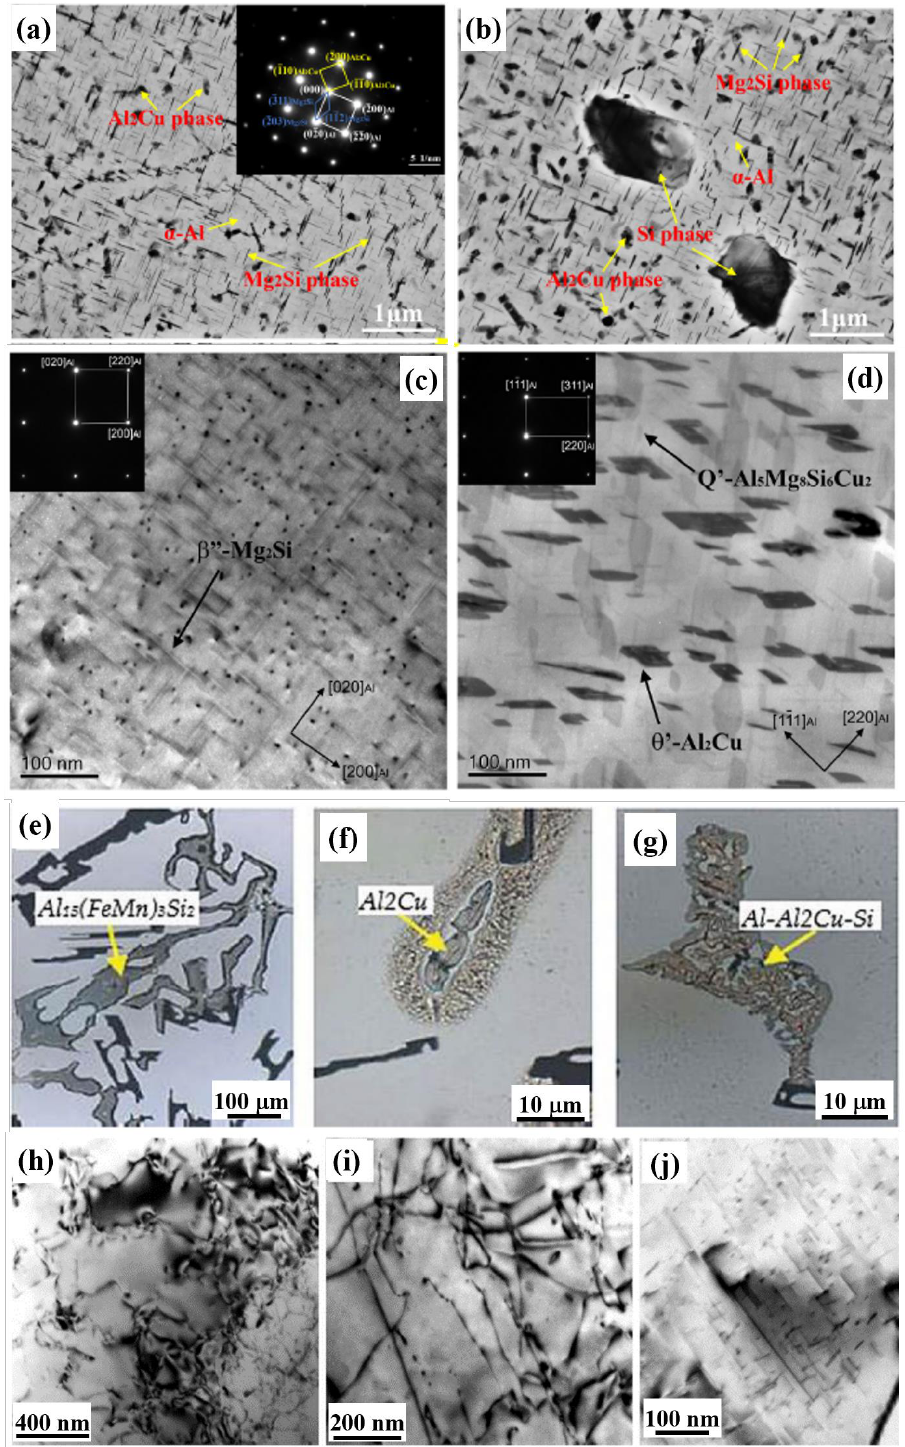
Figure 6. Bright-field (BF)-TEM images showing the presence of Mg 2 Si and Al 2 Cu precipitates in A319-T6 alloys at a cooling rate of ( a ) 0.1 °C/s and ( b ) 10 °C/s [62]. BF-TEM showing orientation and morphology of the precipitates formed in the α -Al matrix for ( c ) Al-7%Si-0.3%Mg-V-Zr alloy and ( d ) Al-7%Si-3%Cu-0.3%Mg-V-Zr alloy [65]. ( e – g ) Intermetallics precipitated in Al-9%Si-3%Cu recycled alloy [201]. TEM images showing the effect of heat treatment on the precipitation sequence in ( h ) T1, ( i ) T4, and ( j ) T6 states of Al-12.7%Si-0.7Mg alloy [150]. Reproduced with permission from Elsevier, Frontiers, and